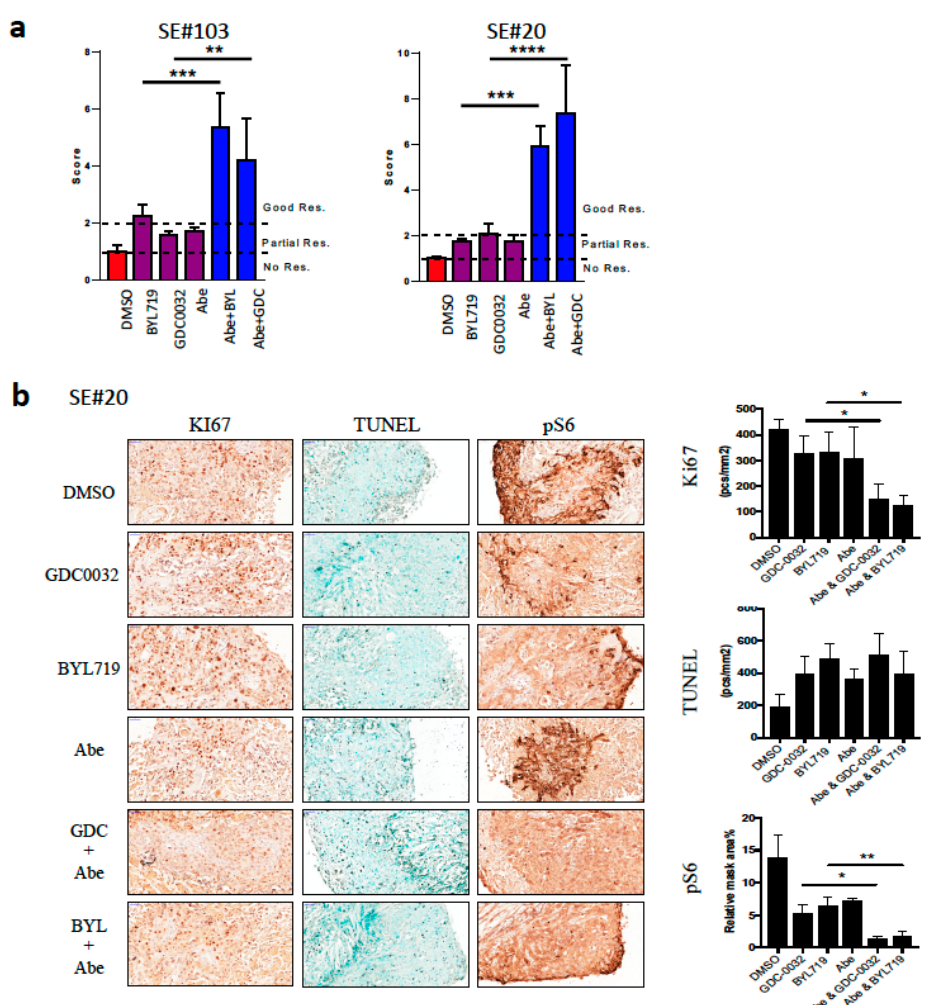
Figure 5. Combination of PI3K and CDK 4/6 inhibitors display synergistic effect in a patient-derived xenograft (PDX) tumor ex-vivo analysis (TEVA). ( a ) TEVA score analysis of SE#20 and SE#103 at 24 h